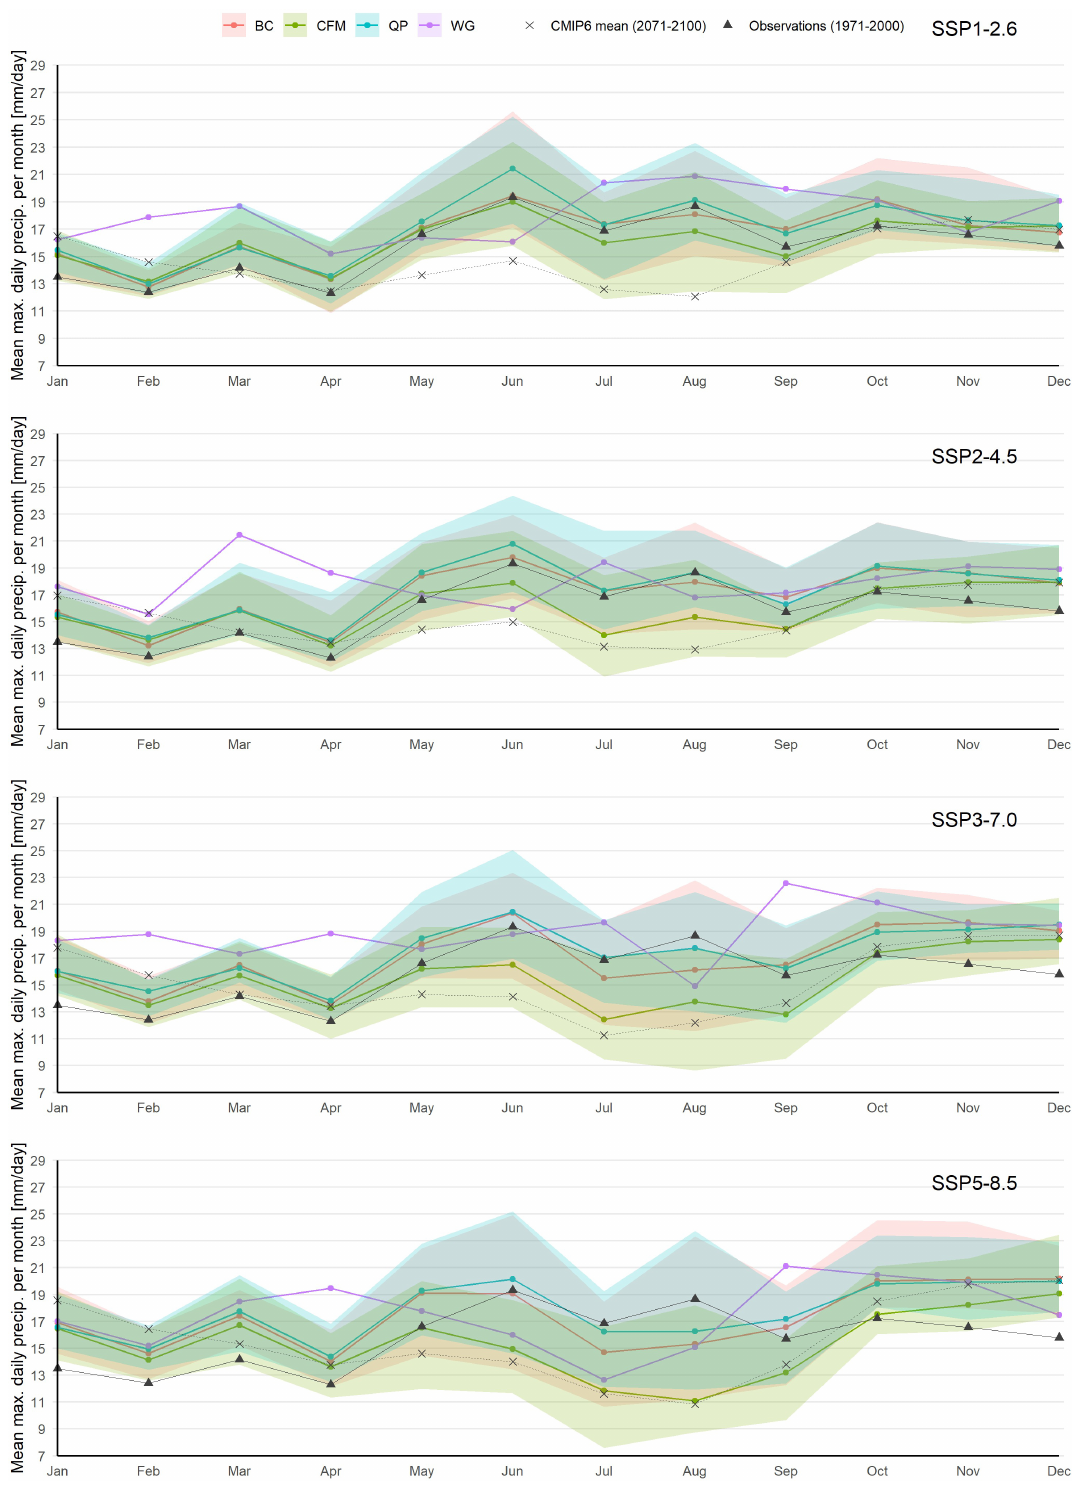
Figure 8. Graphical representation of results for maximum daily precipitation under different future scenarios. Coloured lines represent median values of the ensemble, shades represent the variation within the ensemble (10%–90% quantiles). CMIP6 GCM projections (not downscaled; dashed line) and Uccle observations (solid line) are given as a